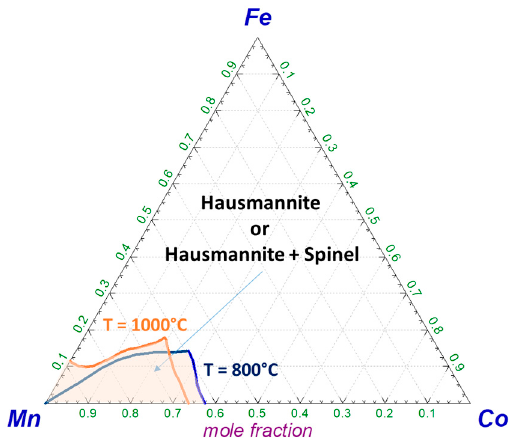
Figure 8. Composition domain containing the Hausmannite phase in the ternary system Mn-Co-Fe-O in air, at 800 and 1000 °C (from [61]).